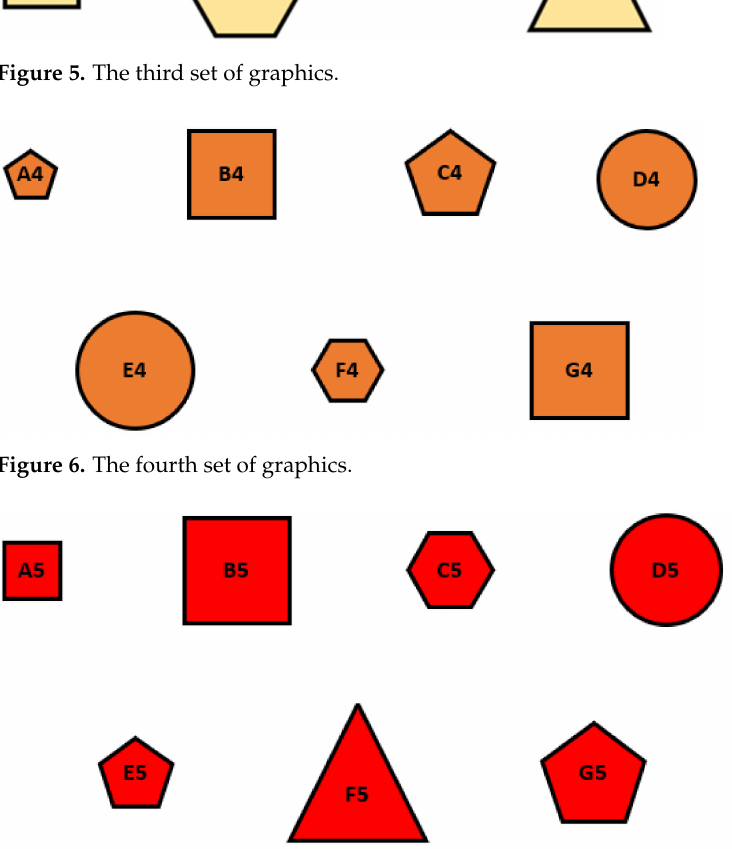
Figure 7. The fifth set of